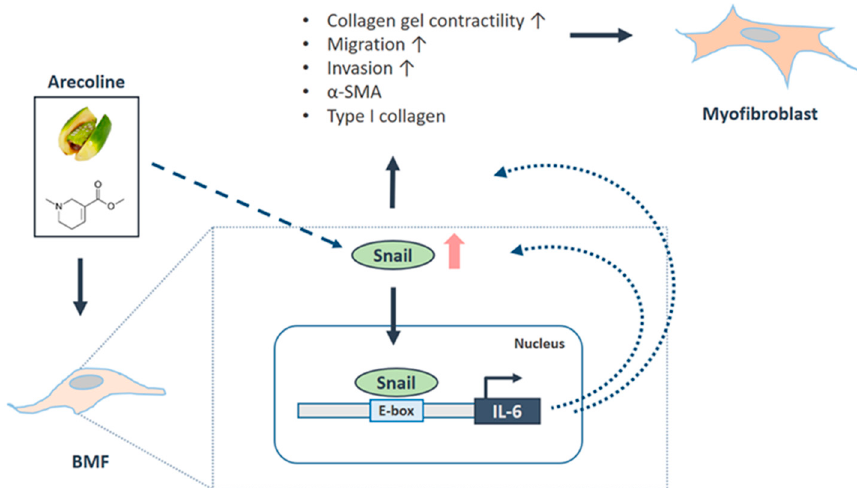
Figure 7. Schematic diagram of the role of Snail in OSF progression. Arecoline, a major alkaloid from the areca nut, activates the transdifferentiation of buccal mucosal fibroblasts (BMF) into myofibroblasts (including the increased phenotypes and fibrosis markers) via the upregulation of Snail. Besides this, the arecoline-induced Snail directly binds to the promoter of IL-6, which further augments the expression of Snail and mediates the Snail-induced myofibroblast activation. Altogether, these findings demonstrate that arecoline triggered a positive feedback loop for Snail and IL-6 to promote the oral fibrogenesis.